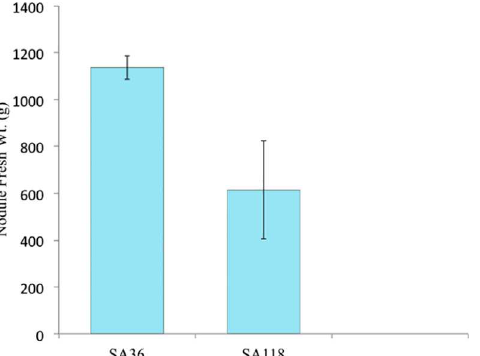
Fig 4. Nodule fresh weight (per plant) difference between SA36 and SA118 grown under nitrogen fixing conditions.